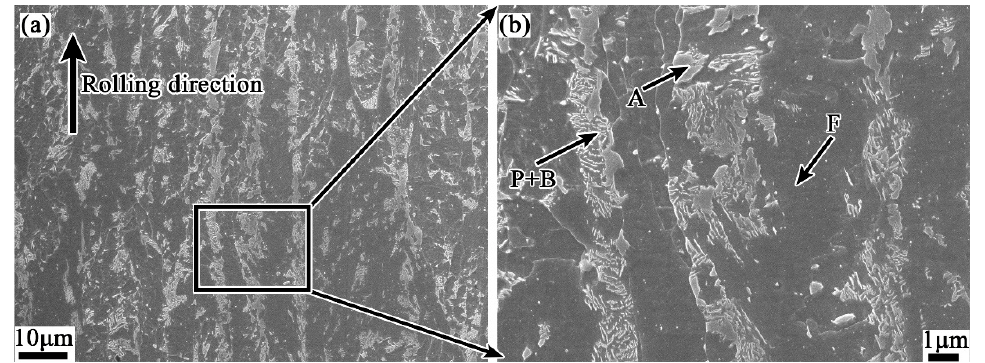
Figure 3. Optical micrographs of the tube banded structure for cases of ( a ) H, ( b ) Q and ( c ) QT1 specimens with their in-band higher magnification images ( a’ ), ( b’ ) and ( c’ ), respectively.